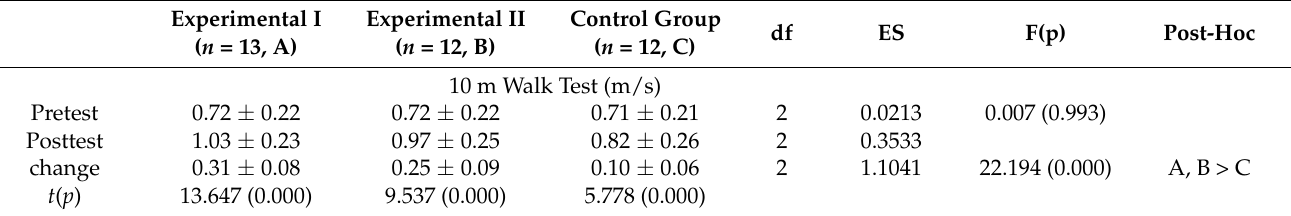
Table 5. Comparison of 10MWT among the three